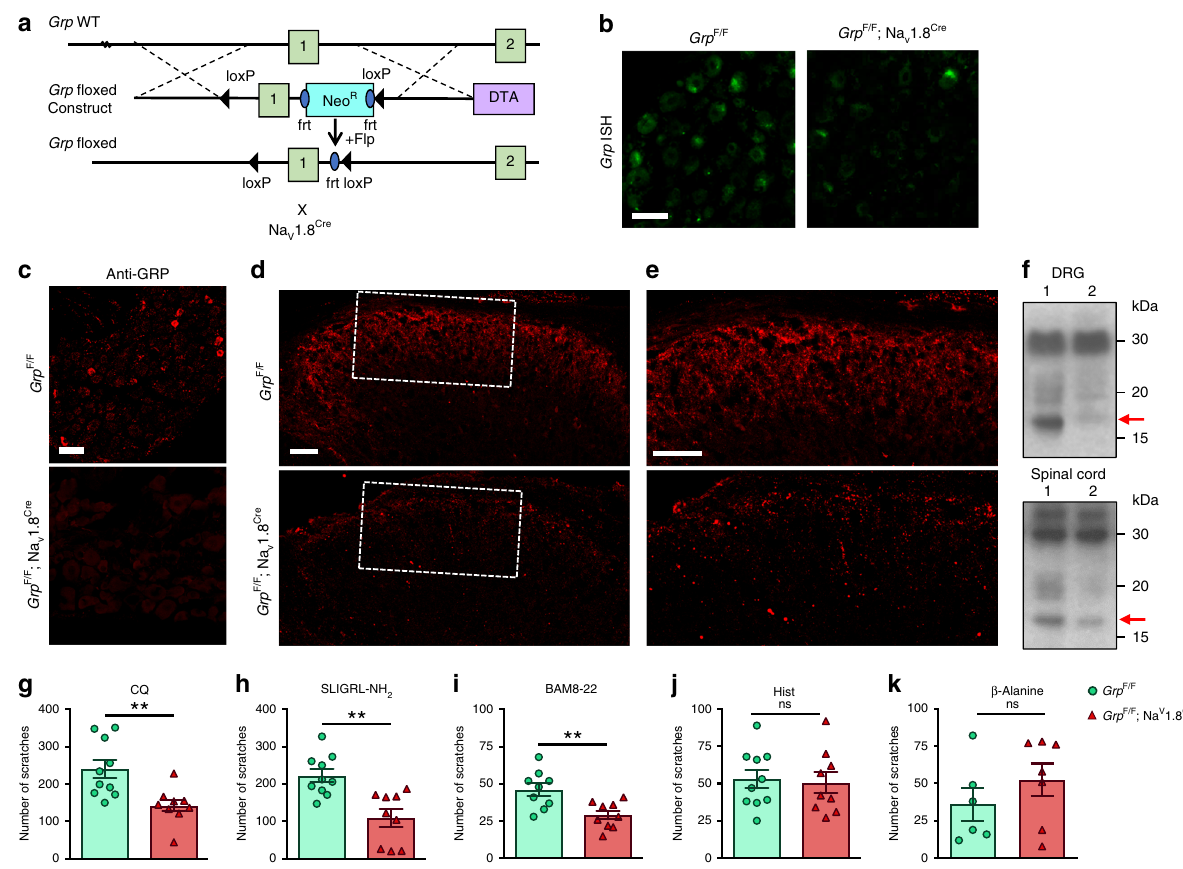
Fig. 6 Attenuated itch behaviors in mice with conditional deletion of Grp in sensory neurons. a Schematic of targeting strategy for inserting loxP sites into Grp allele to generate Grp fl oxed ( Grp F/F ) mice and subsequent crossing with Na v 1.8 Cre mice. b ISH images of Grp expression in DRG sections from Grp F/F and Grp F/F ; Na v 1.8 Cre mice. Scale bar, 50 μ m. c IHC images of GRP antibody in DRG sections from Grp F/F and Grp F/F ; Na v 1.8 Cre mice. Scale bar, 50 μ m. d IHC images of GRP antibody in spinal cord sections from Grp F/F and Grp F/F ; Na v 1.8 Cre mice. Scale bar, 100 μ m. e High power images of boxed area in d . Scale bar, 100 μ m. f Western blot of GRP in DRG (upper row) and the spinal cord (lower row) from Grp F/F (lane 1) and Grp F/F ; Na v 1.8 Cre mice (lane 2). Arrow, predicted size of pro-GRP at 15.6 kDa. g – k Mean number of scratches induced by i.d. nape injection of ( g ) CQ (200 μ g), ( h ) SLIGRL-NH 2 (100 μ g), ( i ) BAM8-22 (100 μ g), ( j ) Hist (200 μ g), and ( k ) β -alanine (100 µ g) in Grp F/F and Grp F/F ; Na v 1.8 Cre littermates. Data are presented as mean ± s.e.m., n = 9 mice for Grp F/F and 10 mice for Grp F/F;Na v 1.8Cre in g – j . n = 6 mice for Grp F/F and 7 mice for Grp F/F;Na v 1.8Cre in k . ** p < 0.01, unpaired two tails t test in g – k . Source data are provided as a Source Data fi